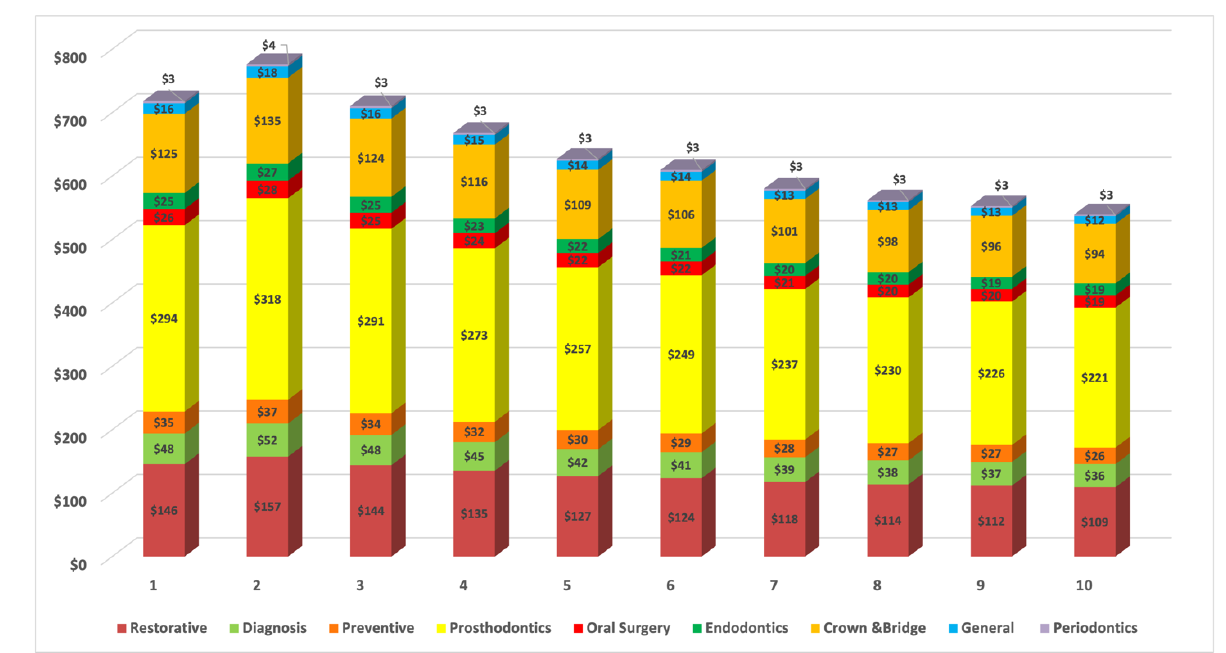
Figure 2. Cost (million Australian dollars, AUD) of dental services utilisation of older population by IRSD, socioeconomic deprivation deciles (1 – 10). New South Wales (NSW); South Australia (SA); Victoria (Vic); Queensland (Qld); Tasmania (Tas) and Western Australia (WA), the Australian Capital Territory (ACT) and the Northern Territory (NT).